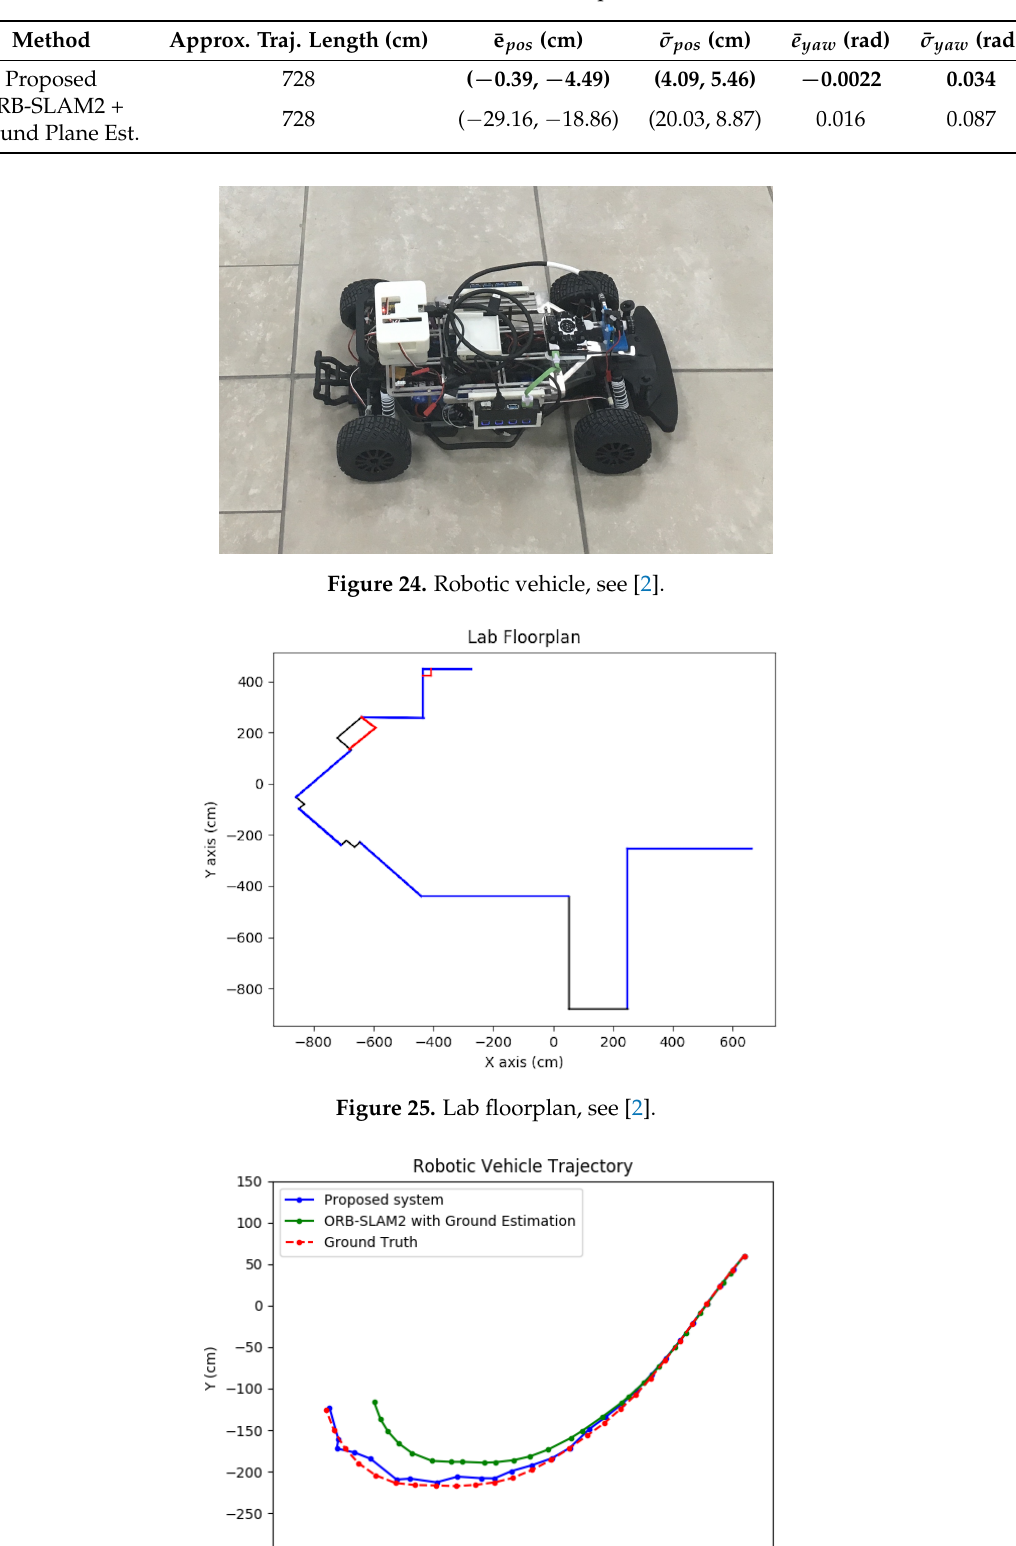
Table 5. Real-world test comparison.